Question: Does the figure show an increasing or a decreasing trend?
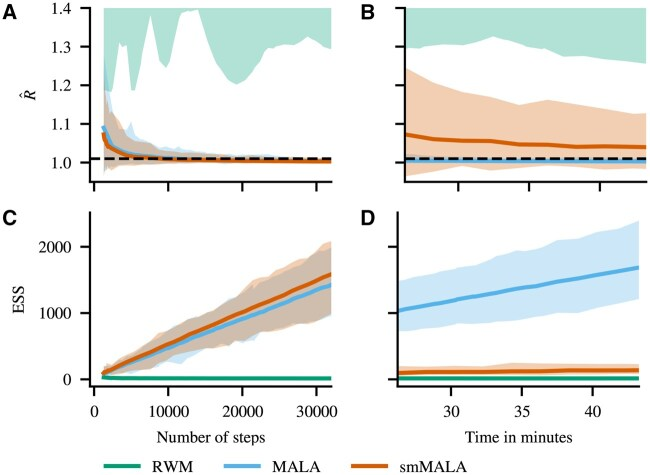
Answer: increasing